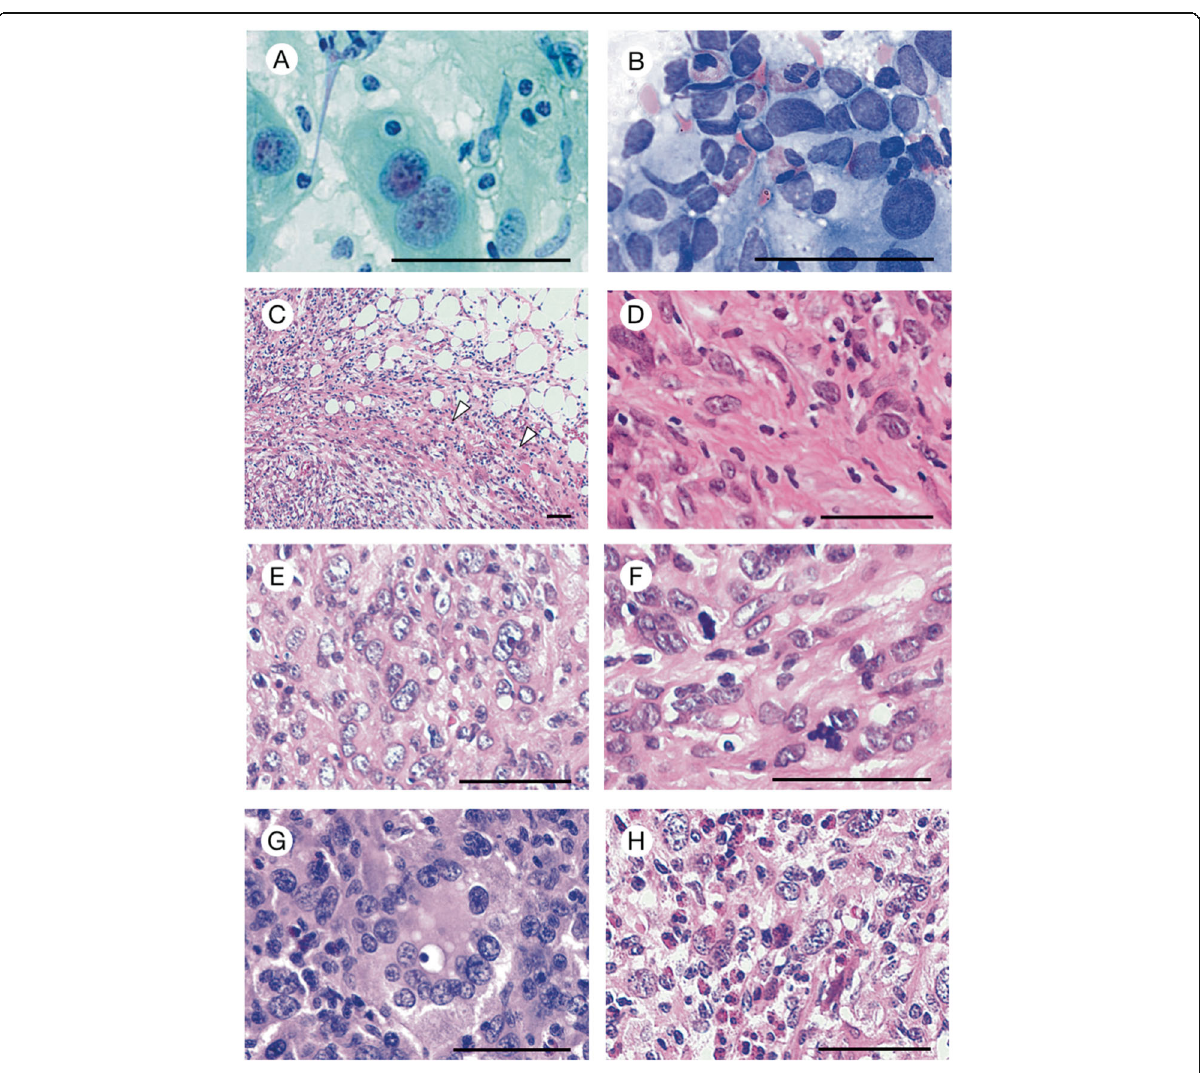
Fig. 2 Cytological and histological findings of the lymph node: Mononuclear and multinuclear neoplastic cells were intermingled in an inflammatory background including several eosinophils ( a , Papanicolaou stain; b , May-Grunwald Giemsa stain ). These were large and round to oval shape, and the nuclei had some nucleoli. An emperipolesis of small lymphocytes was noted. The tumor had a capsule ( Arrowheads ), but neoplastic cells broke through it ( c ). The tumor was composed of large cells which had round to oval or spindle shape with diffuse architecture ( d, e ), and mitoses ( f ) and emperipolesis ( g ) were scattered. Numerous numbers of eosinophils infiltrated into the tumor ( h ). Bars, 50 μ